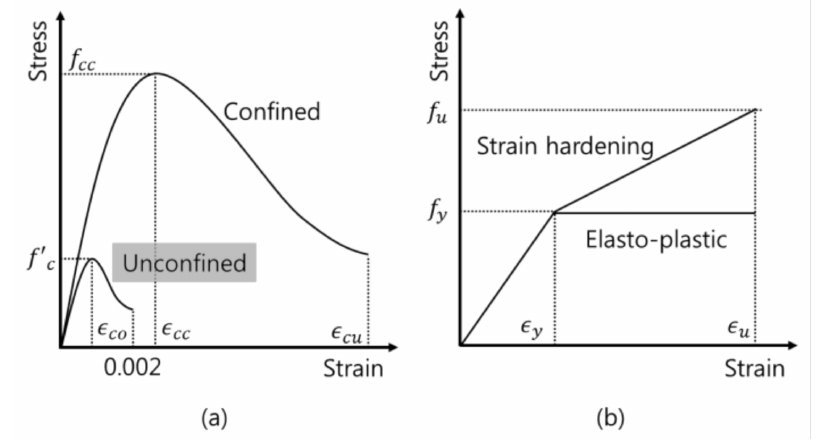
Figure 6. Idealized stress-strain curves: ( a ) concrete, ( b ) steel.